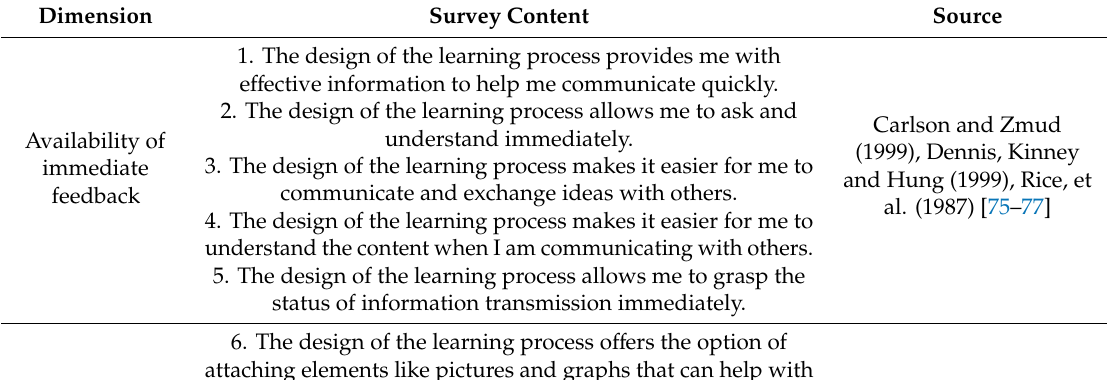
Table 3. Media richness perception measurement